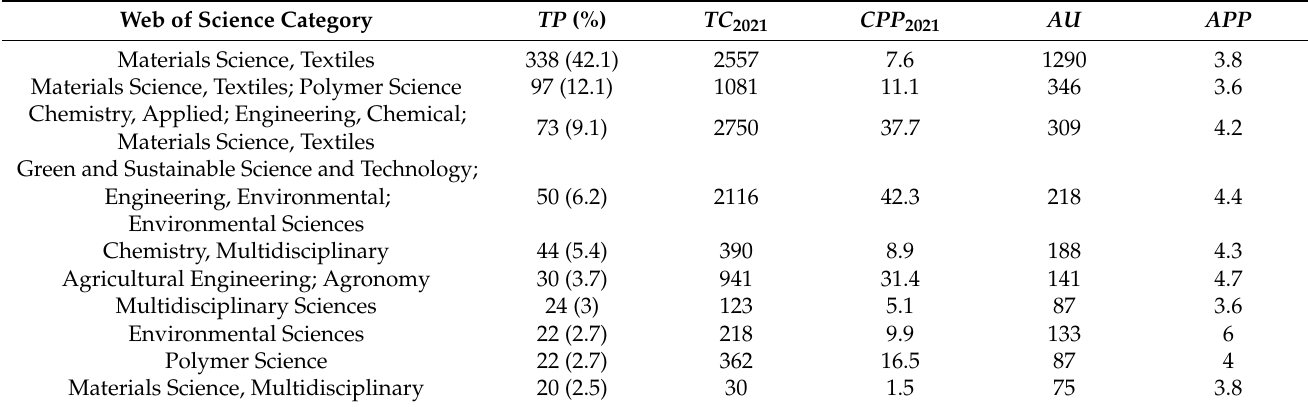
Table 2. The top 10 productive Web of Science